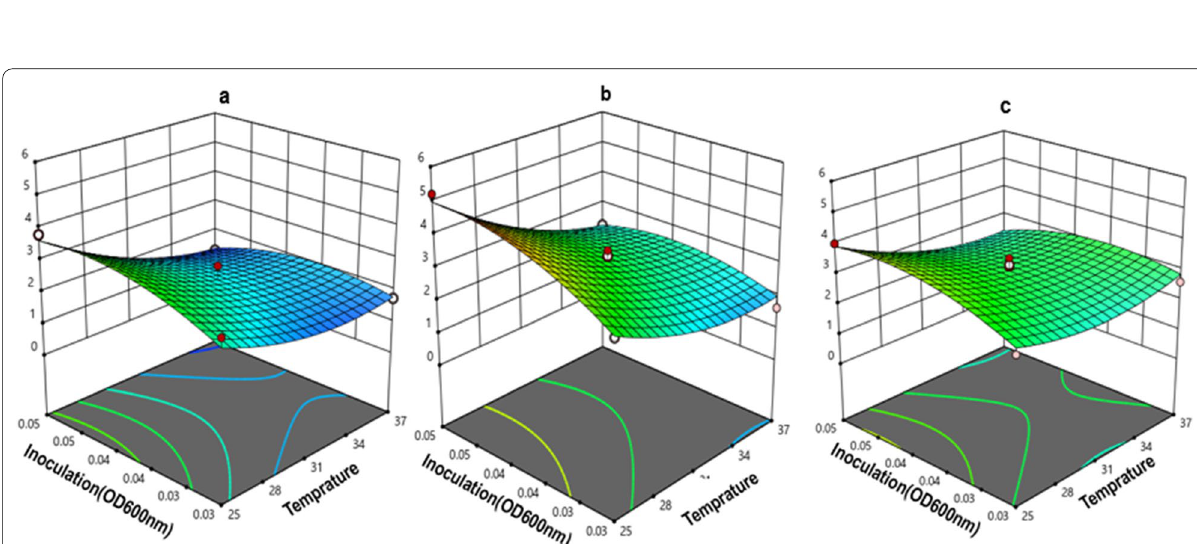
Fig. 2 The effect of inoculum load and temperature on SAK expression at ( a ) LB medium, ( b ) TB medium, and ( c ) 2YT